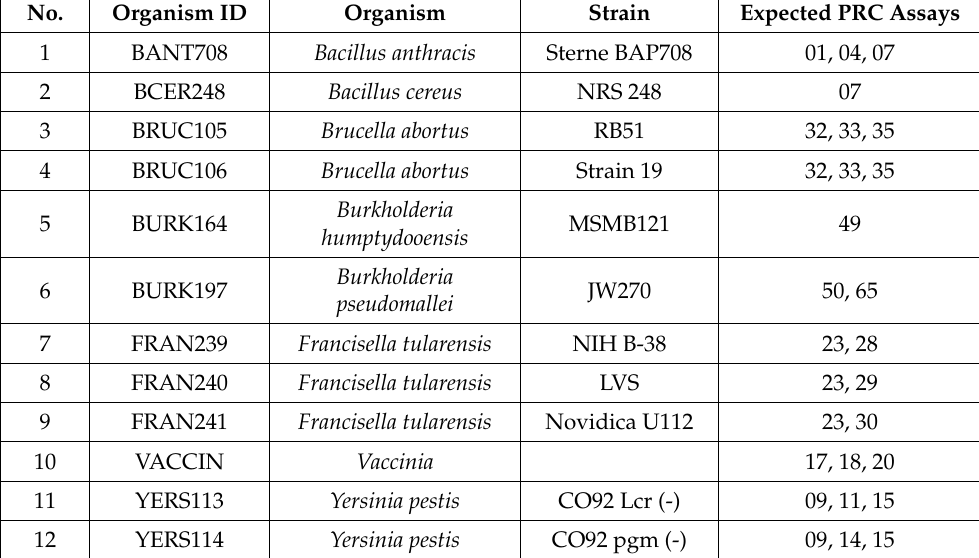
Table 2. Organism ID and strain information for PCR assay targets. Organism ID and strain infor ‐ mation, along with which PCR assays are expected to amplify are shown, totaling 20 unique assays (PCR primer pairs). There are 3 assays specific for Variola virus included in the 23 ‐ plex but not shown in the table because these were not expected to amplify any of the test organisms.